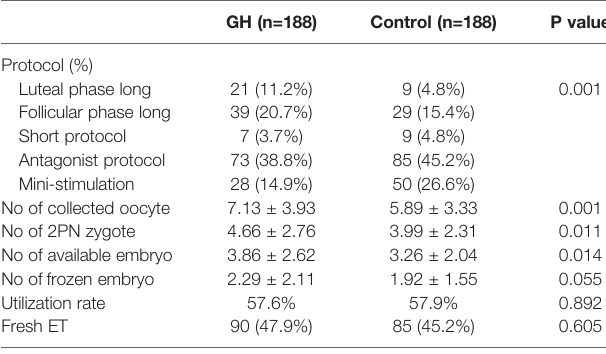
TABLE 2 | Controlled ovarian stimulation (COS) protocol and laboratory parameters in fresh cycle.